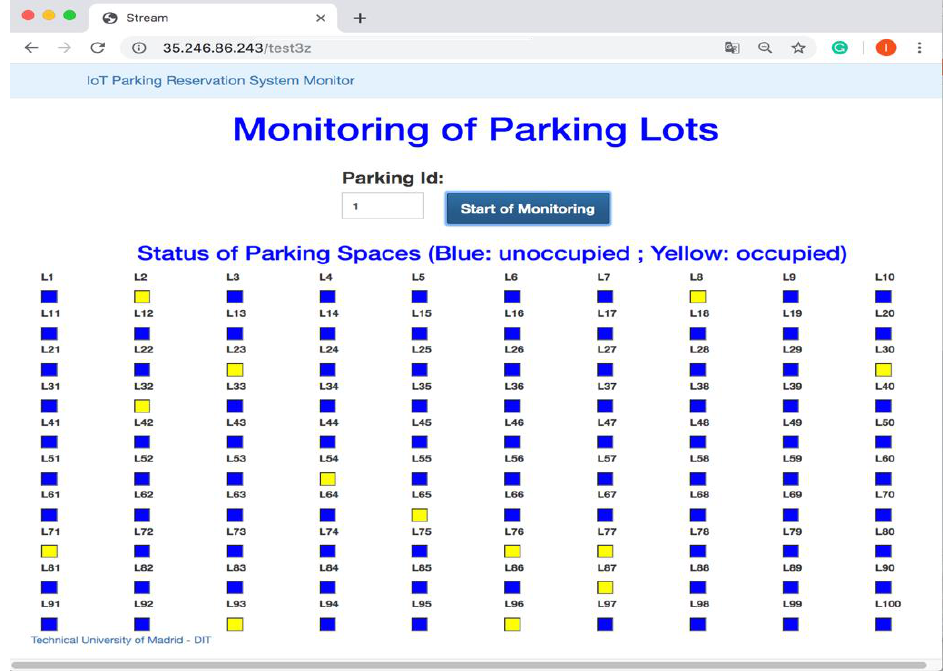
Figure 9. Reservation Request Service interface.